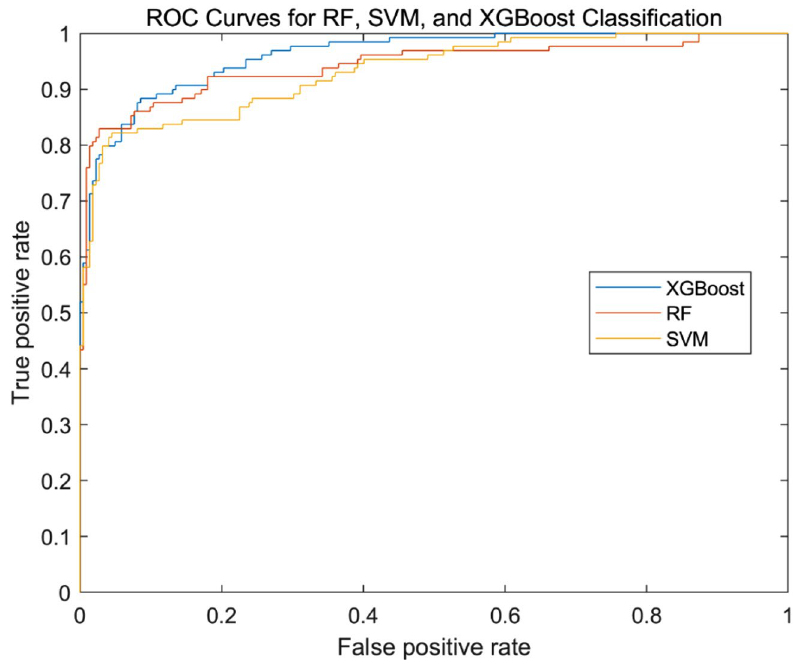
Fig. 9 ROC curves of three classification